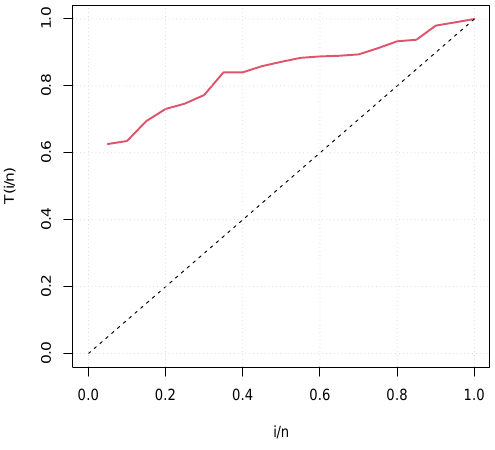
Figure 7. TTT plot of the flood levels data